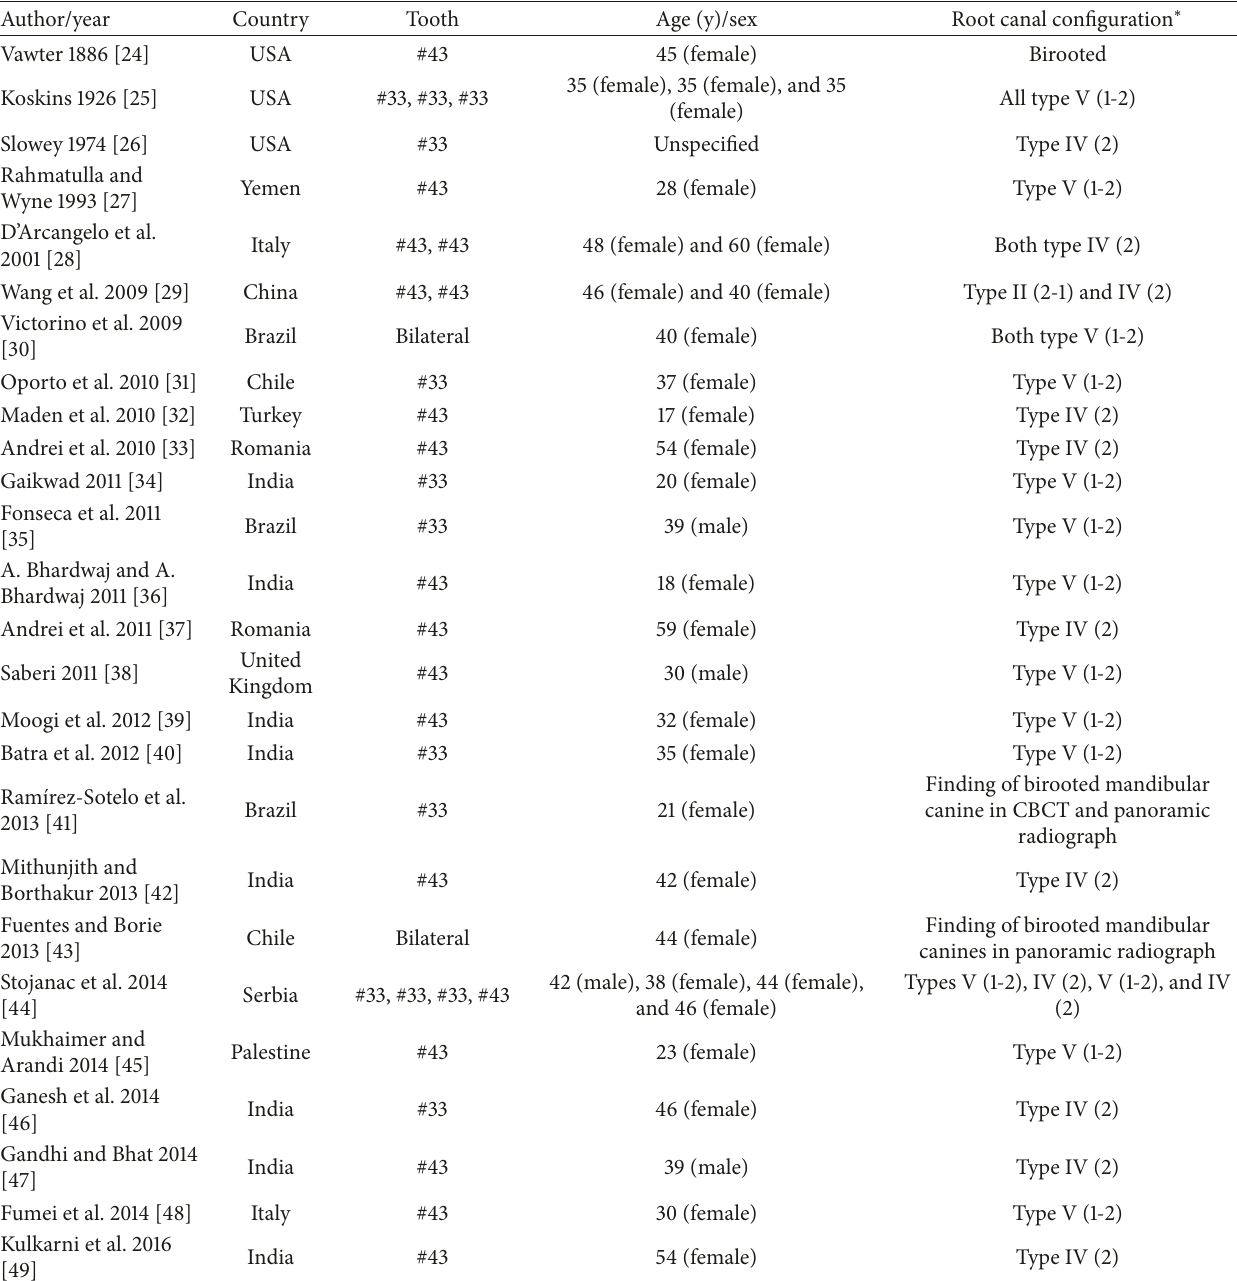
Table 3: Case reports of mandibular canines with two roots and two root canals ( 𝑛 = 26 articles